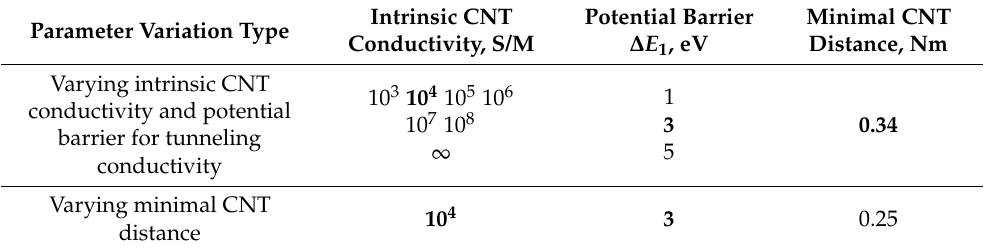
Table 2. Plan of numerical experiments, values in bold correspond to the reference point.